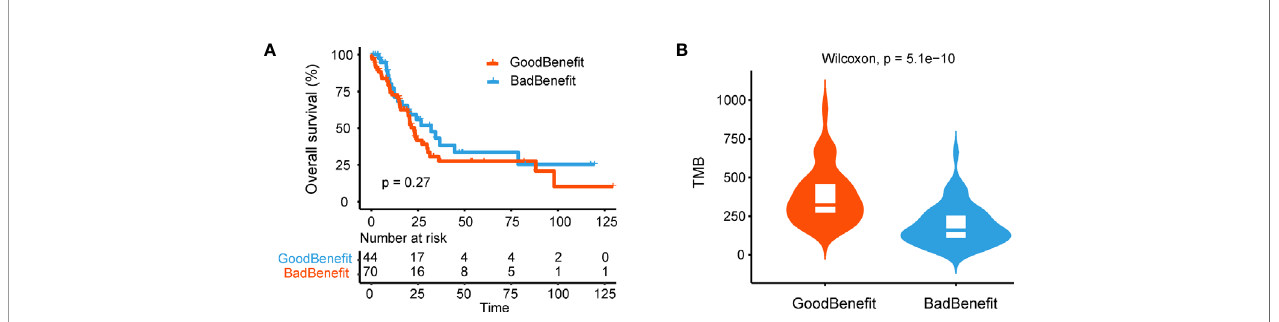
FIGURE 4 | Genomic characteristics of NOTCH/co-DDR co-occurring pathways in TCGA cohort. (A) Kaplan-Meier survival curves for OS comparing “ GoodBene fi t ” versus “ BadBene fi t. ” (B) Violin plot of TMB between “ GoodBene fi t ” versus “ BadBene fi t.